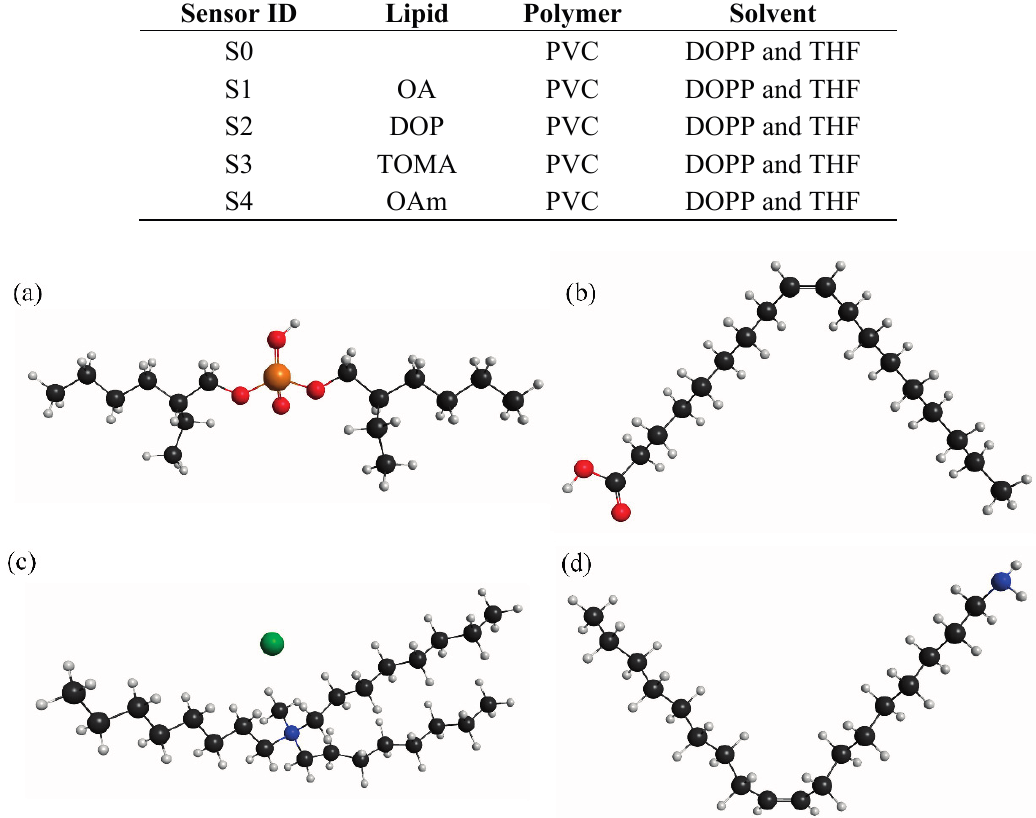
Figure 5. Molecular structures of the lipids: ( a ) oleic acid; ( b ) dioctyl phosphate; ( c ) trioctylmethylammonium chloride; and ( d ) oleyl